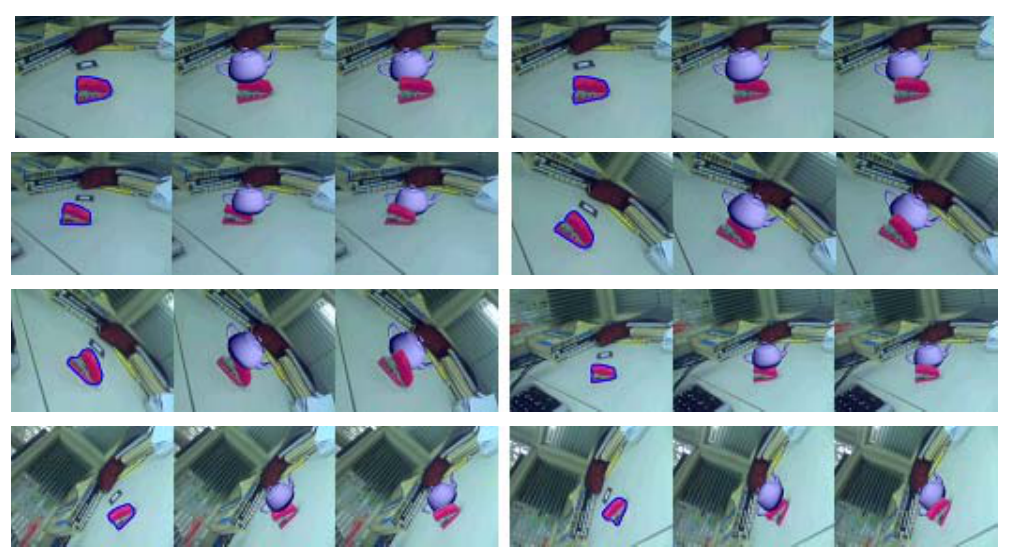
Figure 7. Results of the third experiment.